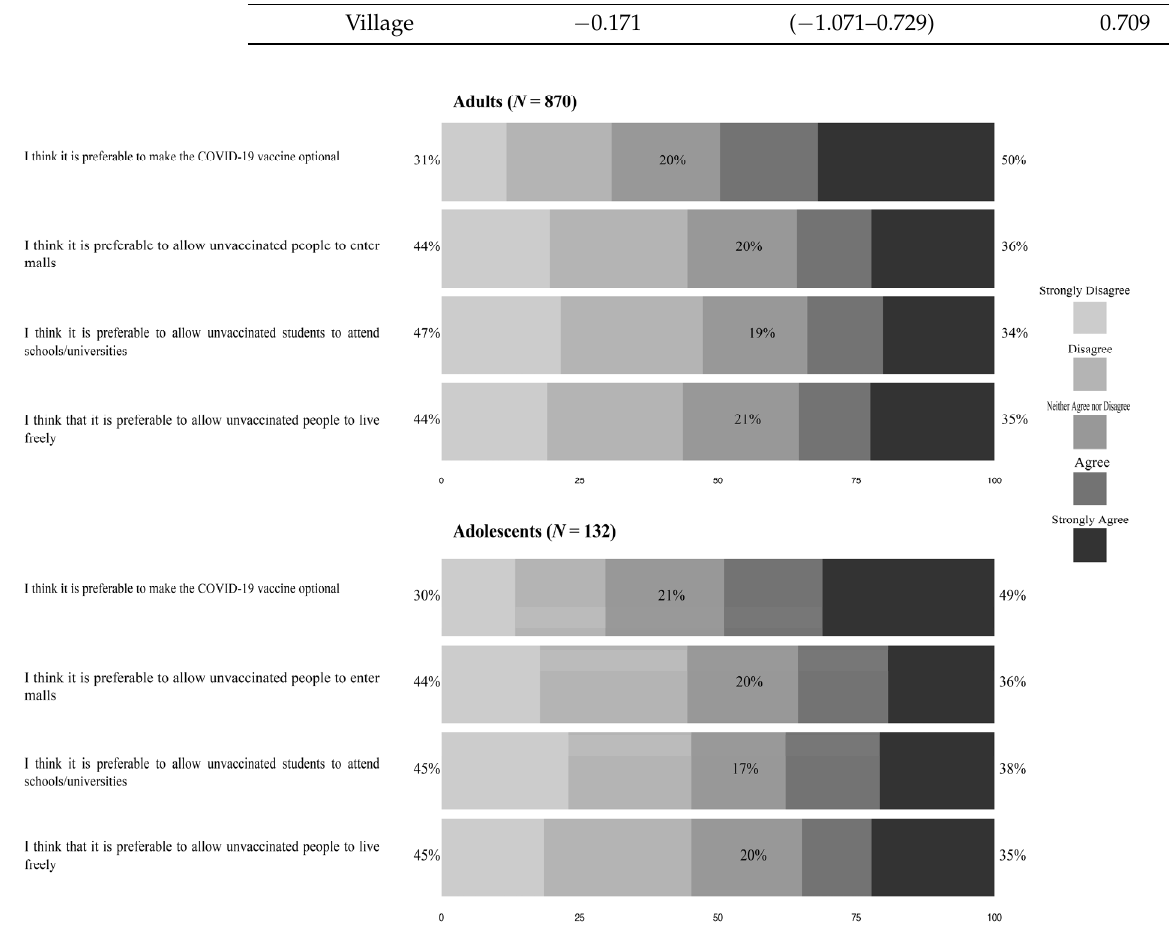
Figure 2. Participants’ opinion about COVID-19 restrictions for unvaccinated